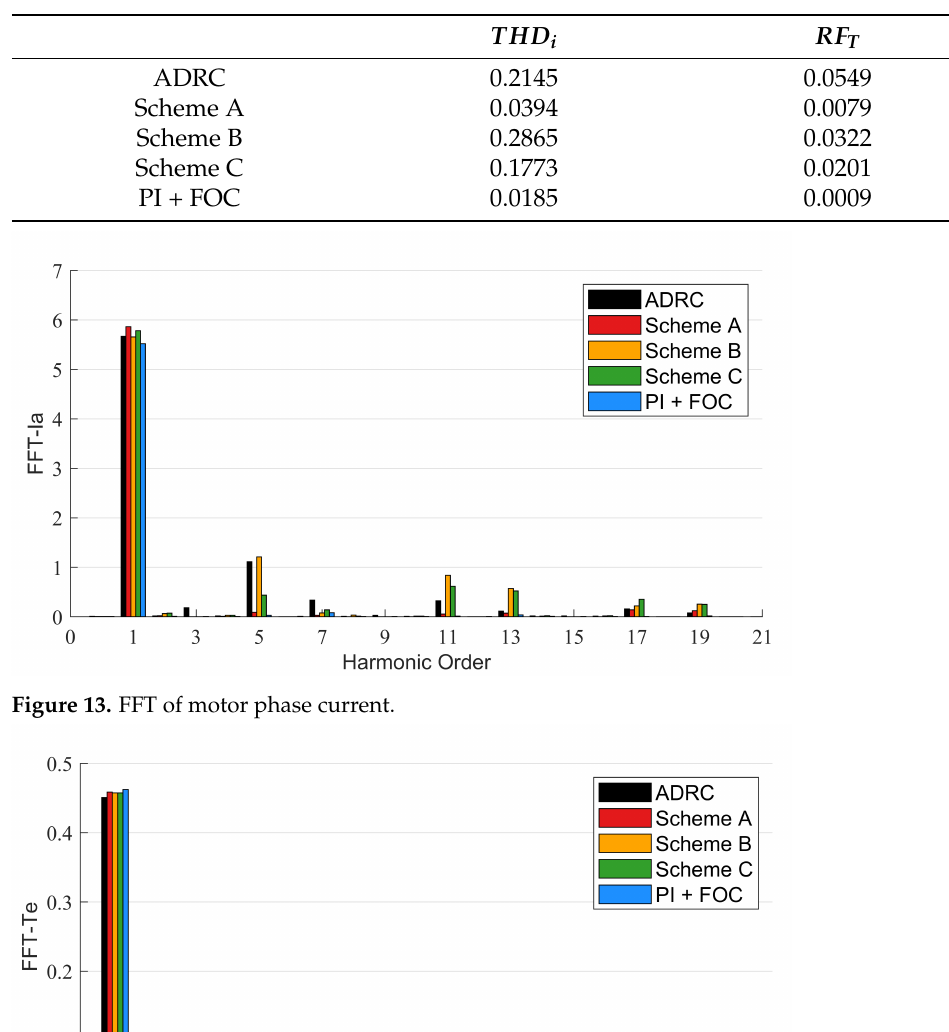
Table 7. THD i of the stator current and RF T of motor torque.